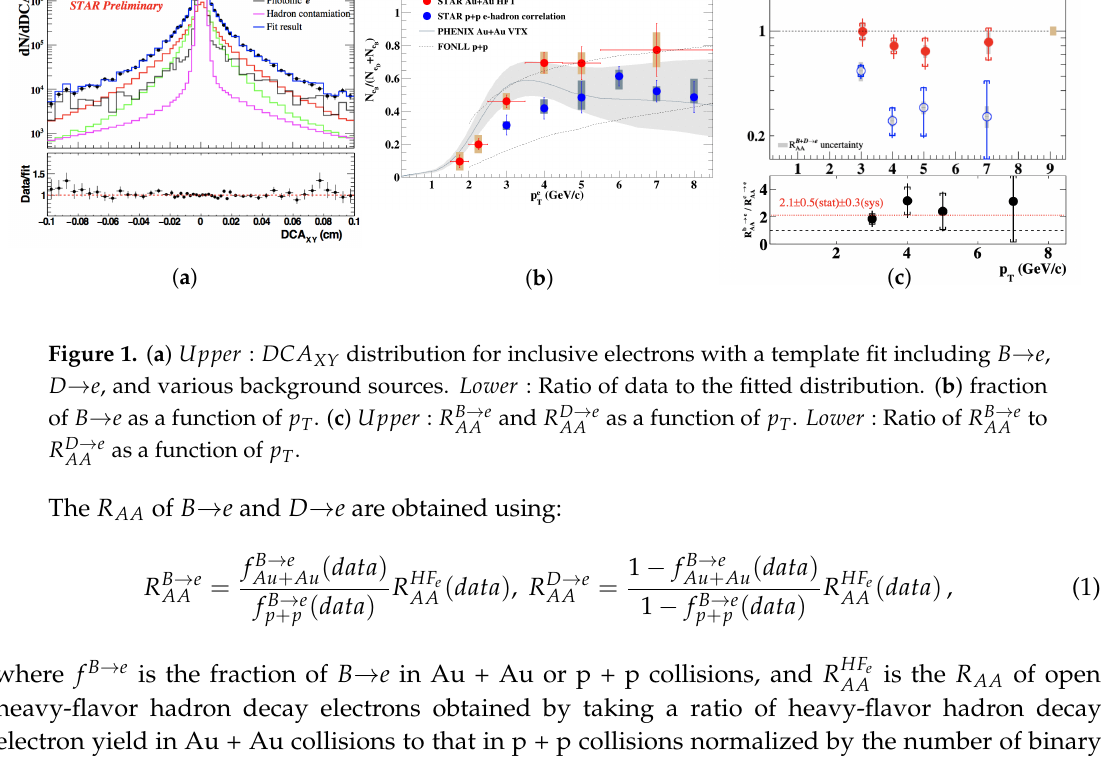
and R D → e as a function of p T . Lower : Ratio of R B → e AA AA